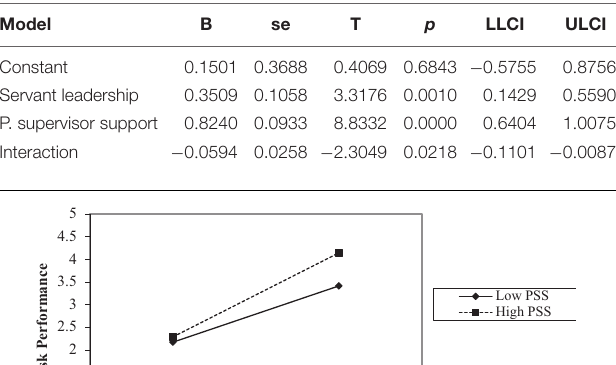
TABLE 4 | Moderation effect on task performance.